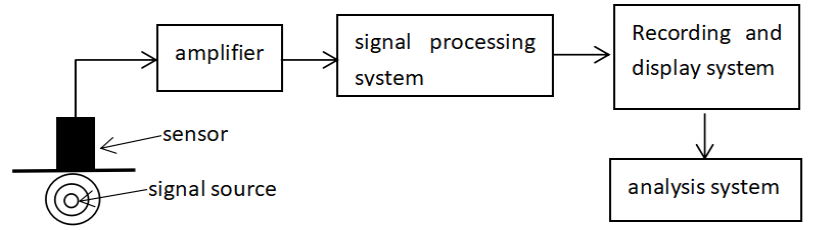
Figure 1. Acoustic emission acquisition principle.